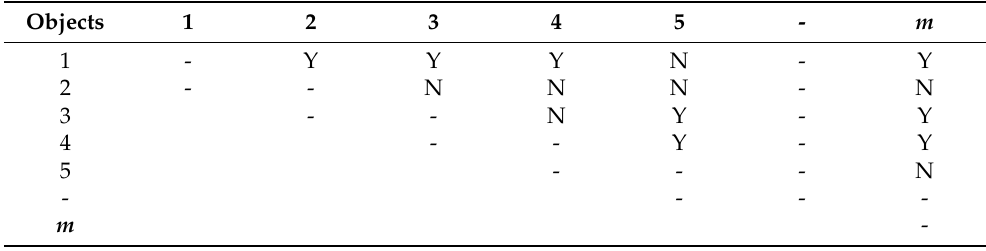
Table 1. Hypothetical choice matrix involving single selector and m objects, Y = yes and N = No.